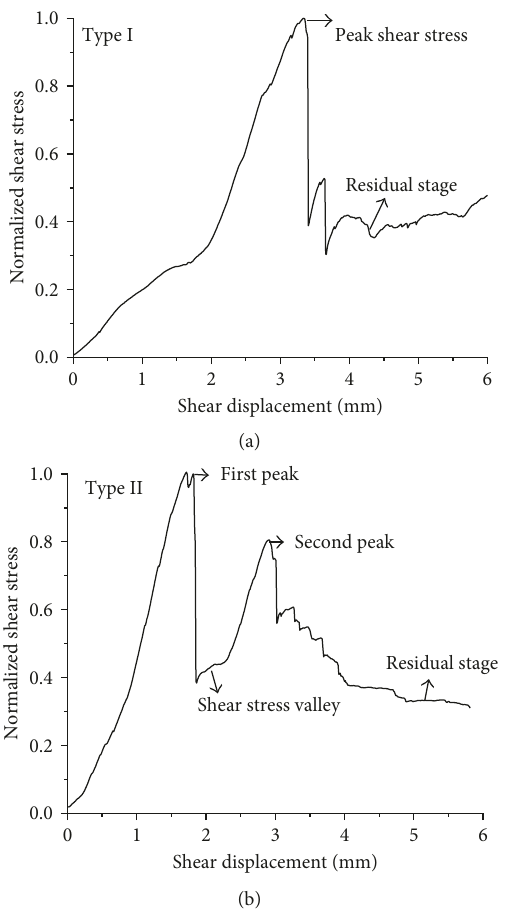
Figure 7: Typical shear curves for (a) single peak and (b) double